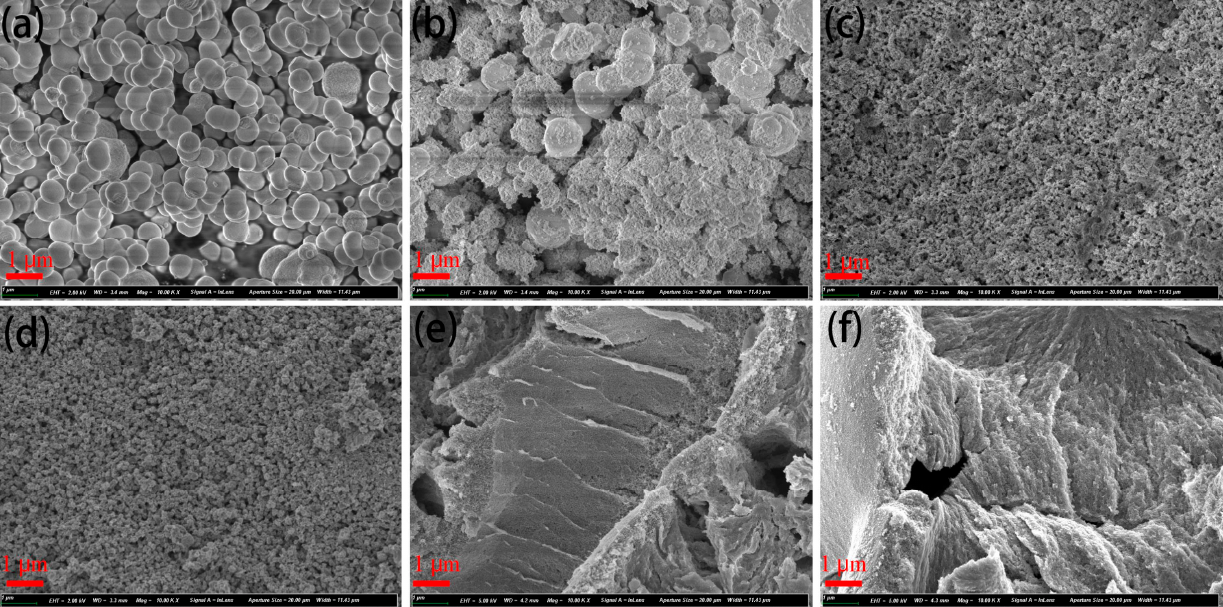
Figure 2. SEM images of ( a ) CeO 2 , ( b ) CeO 2 @ZnO-0.2, ( c ) CeO 2 @ZnO-0.45, ( d ) CeO 2 @ZnO-0.67, ( e ) CeO 2 @ZnO-0.8, and ( f ) ZnO.